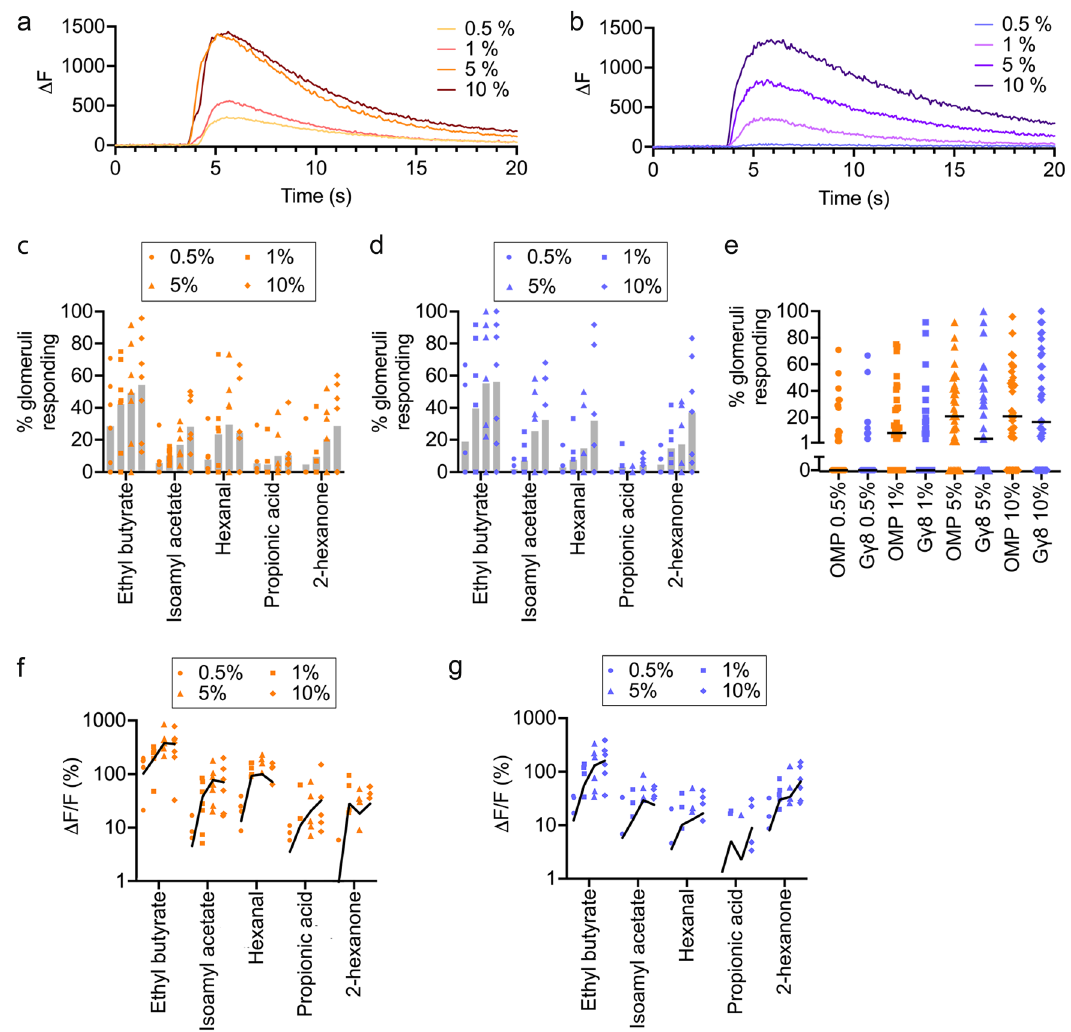
Fig. 3 | Immature OSNs encode odorant concentration. a Responses of an example glomerulus from an OMP-GCaMP6s mouse to the four tested concentra- tions of ethyl butyrate. b Responses of an example glomerulus from a G γ 8- GCaMP6s mouse to the four tested concentrations of ethyl butyrate. c Percentage of glomeruli responding increases with odorant concentration in OMP-GCaMP6s mice (Two-way ANOVA. Effect of concentration: P <0.002, F 3,120 =5.35. Effect of odorant: P <0.001, F 4,120 =11.6. Interaction: P =0.98, F 12,120 =0.36. n =7 mice per group). Bars: mean, symbols: values for individual mice. d Percentage of glomeruli responding increaseswith odorant concentrationinG γ 8-GCaMP6s mice (Two-way